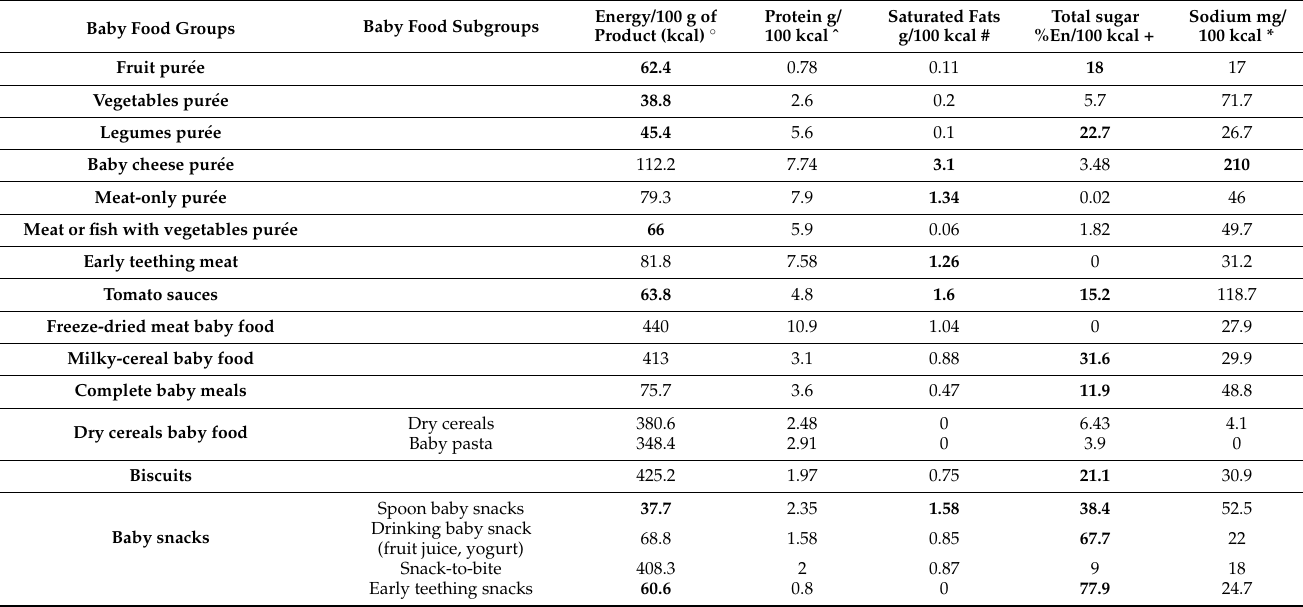
Table 3. Energy and nutrients content of baby foods per 100 kcal or as Energy% 100 kcal [12]. Baby Food